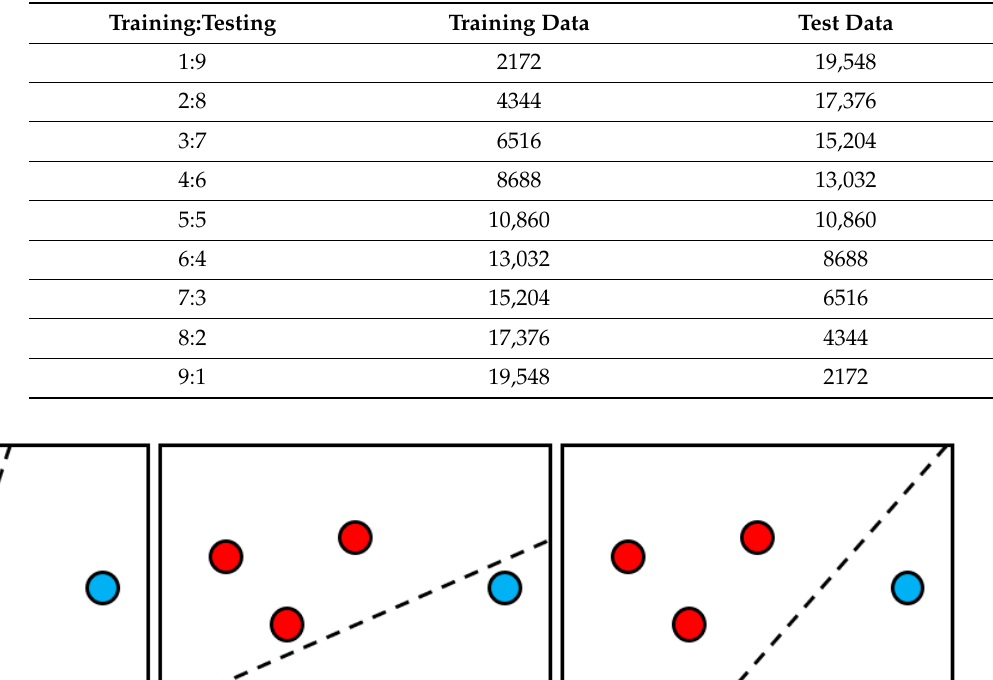
Table 3. Distribution of the training data and test data.